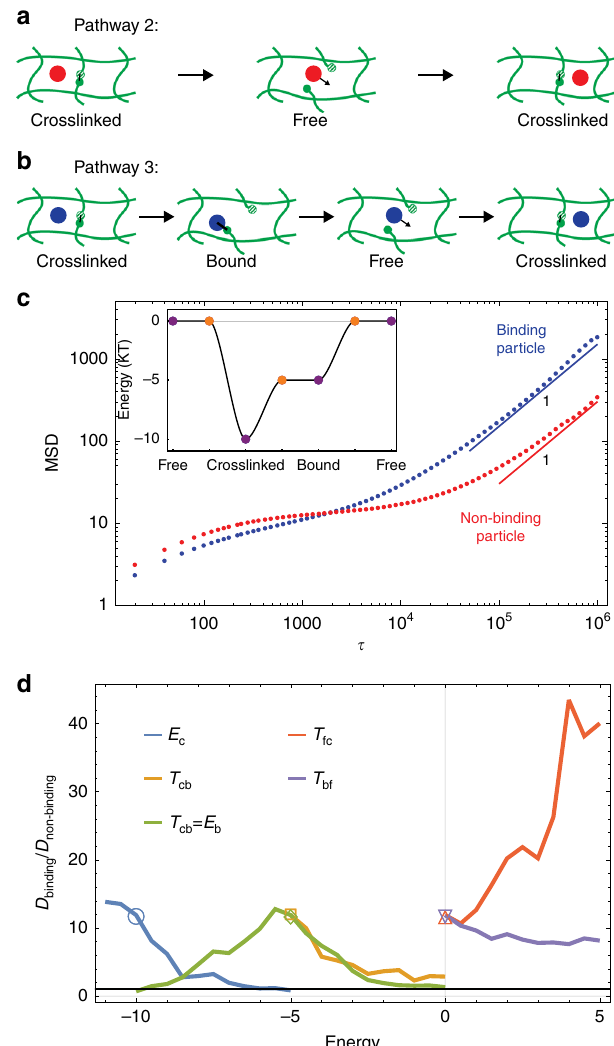
Fig. 5 Enhanced diffusion in a reversible gel with moderate binding af fi nities. a A sketch of how a non-binding particle can diffuse when crosslinks are able to spontaneously break. b A sketch of a third pathway for diffusion that is only available to binding particles. c Mean squared displacement of a binding particle (blue) and a non-binding particle (red). At short time scales, the binding particle moves slower than the non- binding particle because it is bound. However, this binding helps break crosslinks on long-time scales and leads to a higher diffusion constant. See Supplementary Movie 3. d D binding / D non-binding for fi ve slices of the fi ve- dimensional parameter space. Each curve gives D binding / D non-binding while changing one or two of the energies while keeping all the others fi xed. The symbols indicate the point on the curve corresponding to those initial energies. Data are averaged over 50 simulations in c and over 30 simulations for each point in